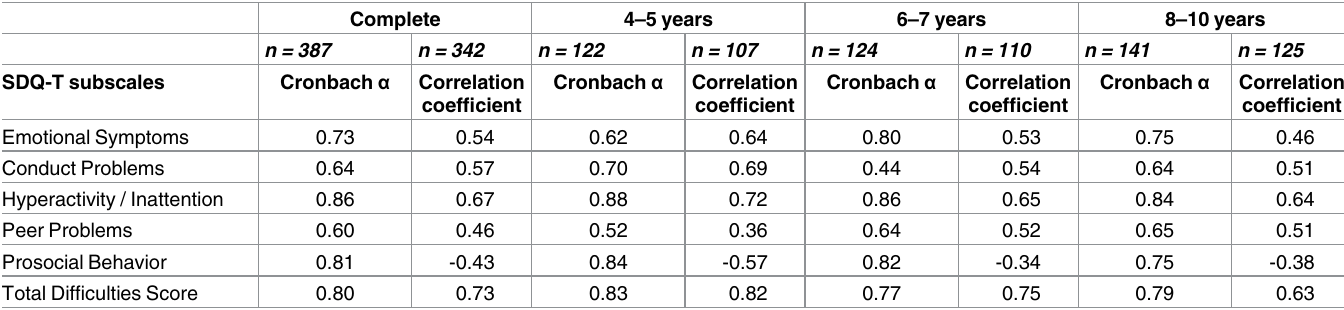
Table 4. Reliability and concurrent validity of the teacher SDQ at different